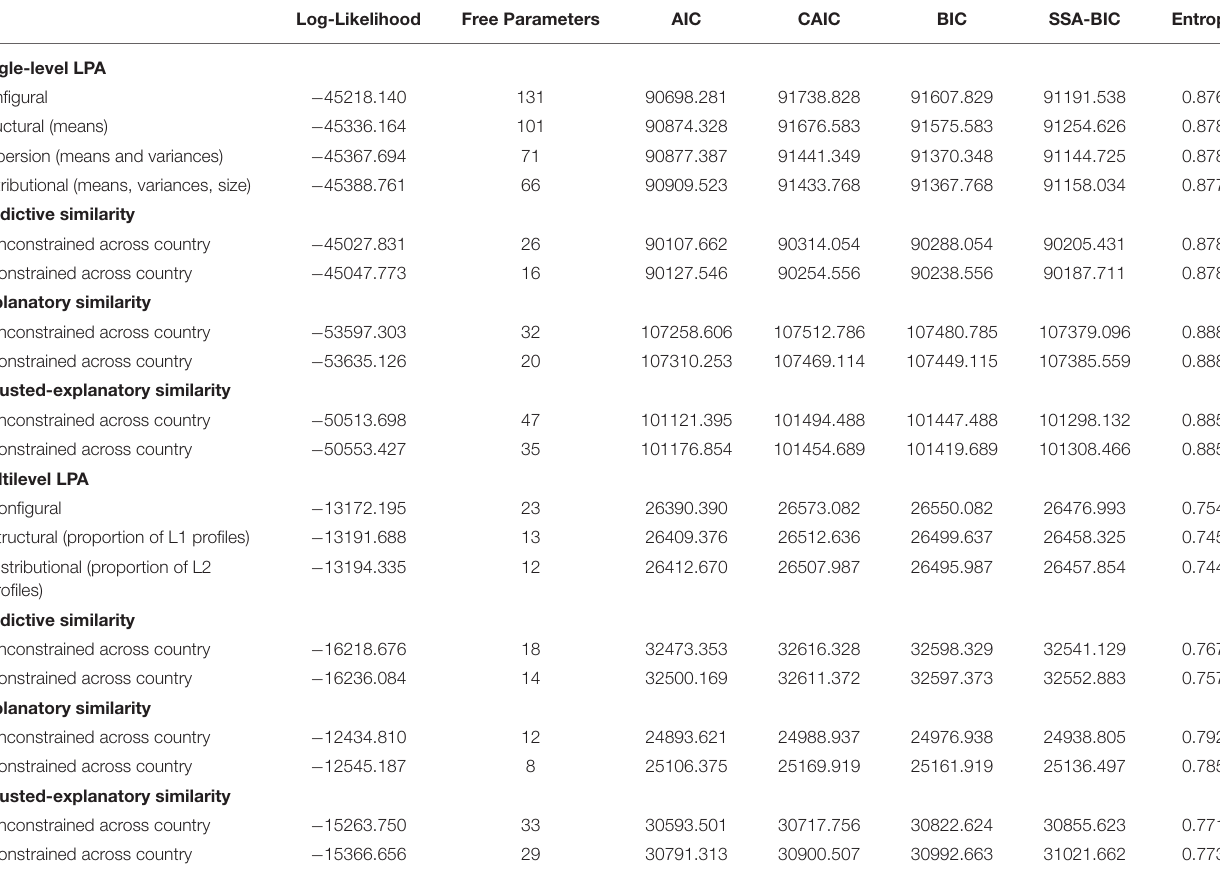
TABLE 3 | Tests of profile similarity across Australia and England. Log-Likelihood Free